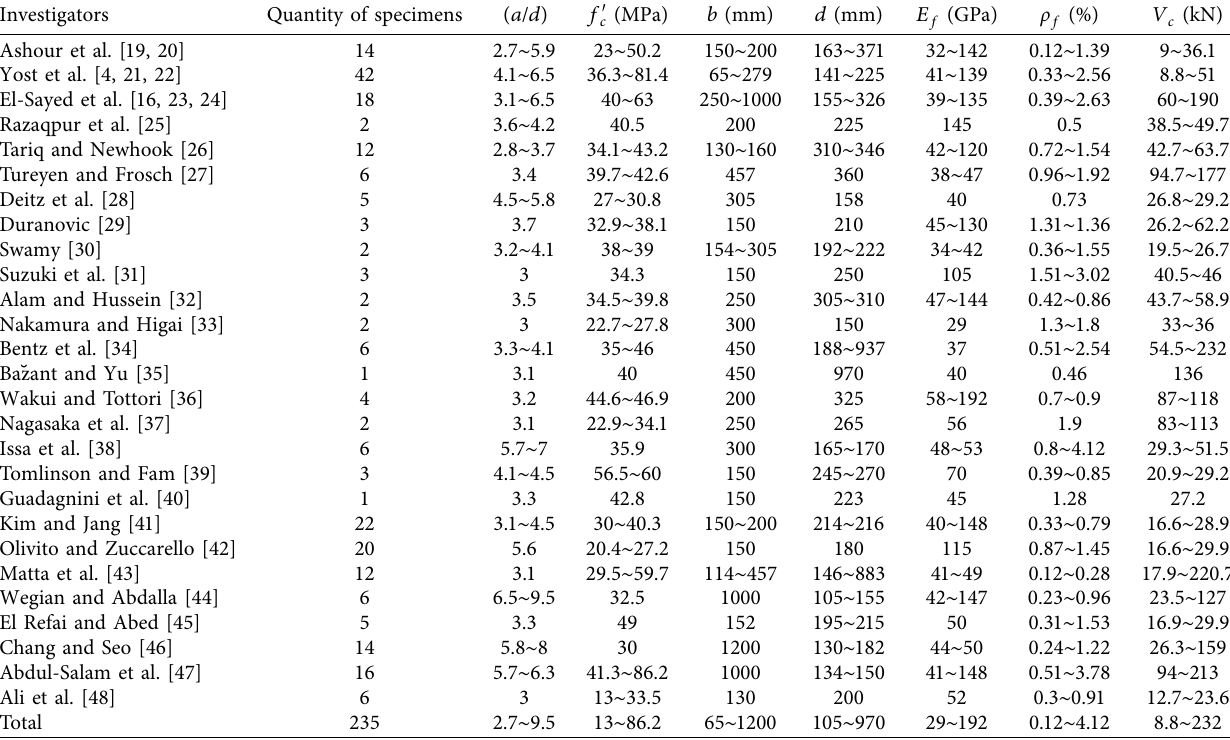
Table 2: Beam specimen details and shear strengths.